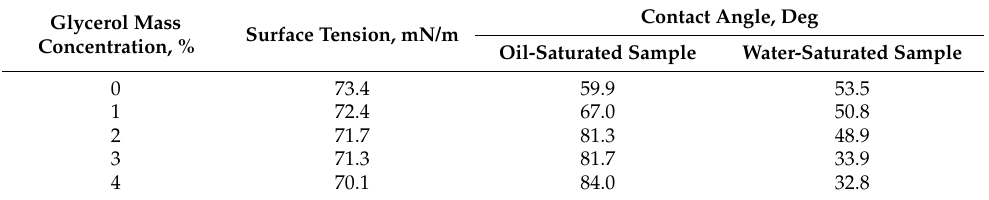
Table 1. Correlation between contact angle values of the shutoff composition and glycerol concentrations.